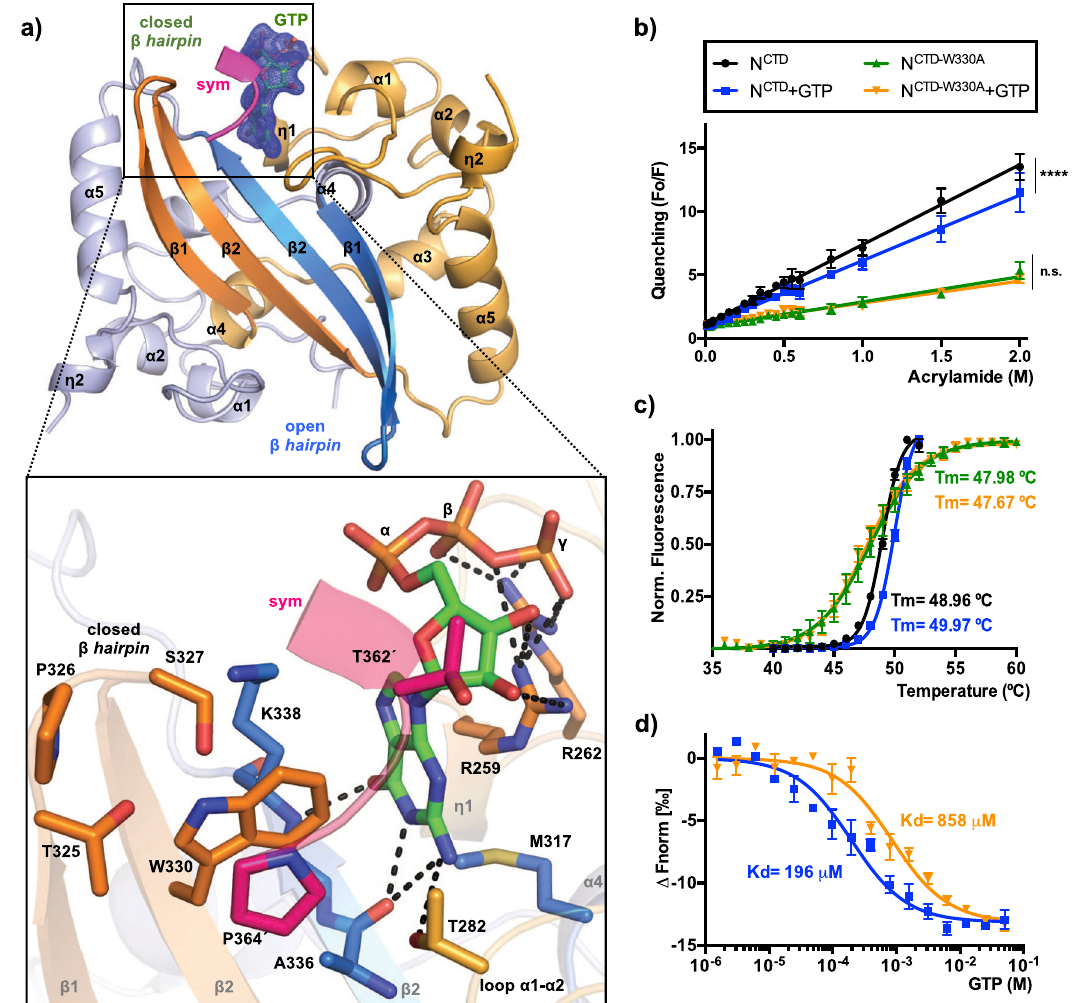
Fig. 3 Crystal structure of SARS-CoV-2 NCTD in complex with GTP. a Upper panel, the N CTD dimer in complex with GTP is represented in the cartoon. Each monomer is colored in blue and orange, respectively. The β -hairpins of the dimer are labeled and highlighted in dark tones. The GTP molecule is shown in sticks with its electron density map 2Fo − Fc ( σ = 1) in green color. The close view of the GTP binding site is represented below. The side chain of key residues and the GTP molecule are shown in sticks with carbon atoms colored according to the monomer to which they belong. H-bond interactions of the ligand are represented as dashed black lines. The C-terminal of the symmetric molecule ( sym ) is colored in magenta with residues indicated with apostrophes. Secondary structural elements are numbered and labeled in order from N to C terminus. Nitrogen, oxygen, and phosphorus atoms are colored in blue, red, and orange, respectively. b Quenching of fl uorescence (Fo/F) represented against increasing concentration of acrylamide for the N CTD and N CTD- W330A proteins in the presence or absence of GTP. Trajectories are fi tted to linear regression. Statistical differences are indicated with asterisks (**** p < 0.0001, n.s. p > 0.05). c Thermal unfolding curves of N CTD and N CTD-W330A in the presence or absence of GTP. Trajectories are fi tted to a sigmoid. The corresponding melting temperature ( T m ) is indicated. d GTP binding quanti fi ed thermophoretically. GTP is titrated to a constant amount of fl uorescently labeled N CTD and N CTD-W330A . The binding af fi nity ( K d ) is indicated. The error bar represents the standard error of the mean of at least four experiments.